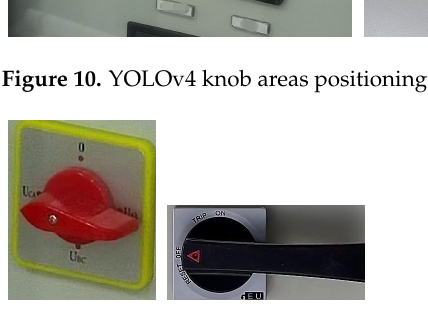
Figure 11. Cropped knob area